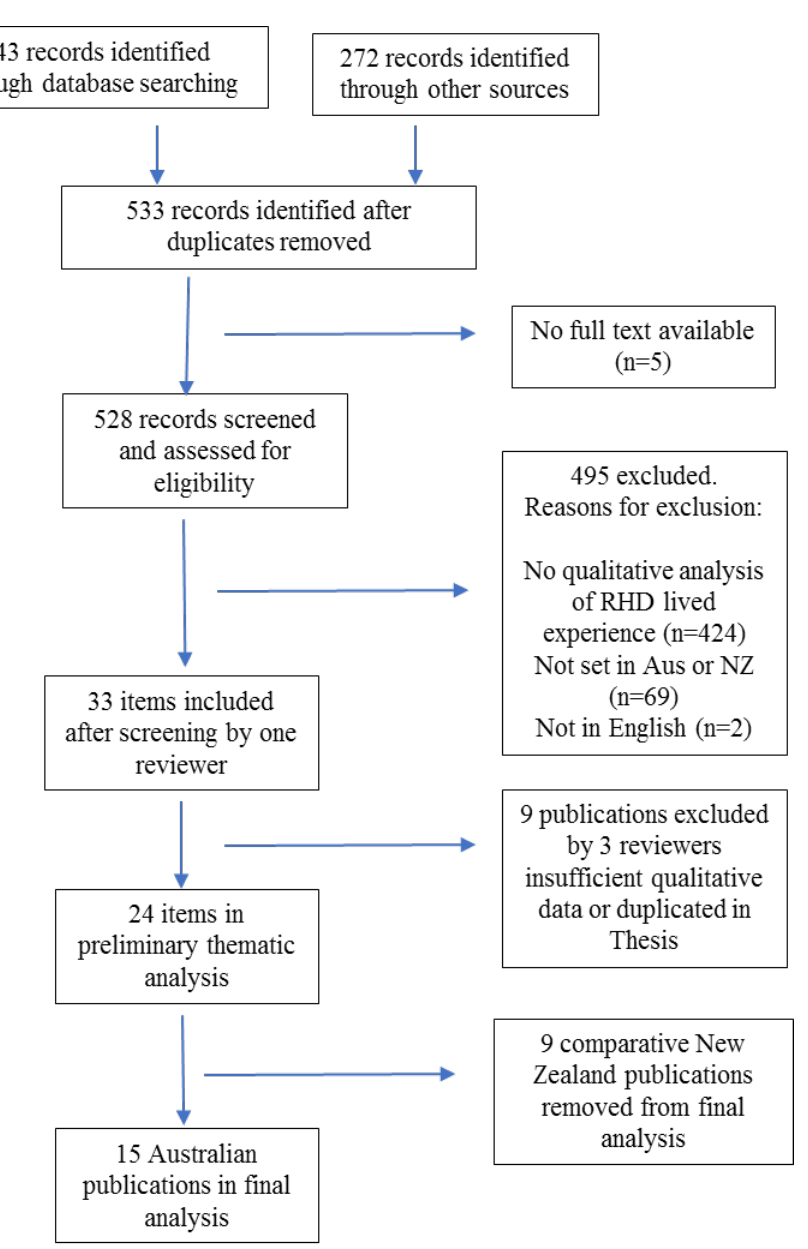
Figure 1. Literature search flow diagram.